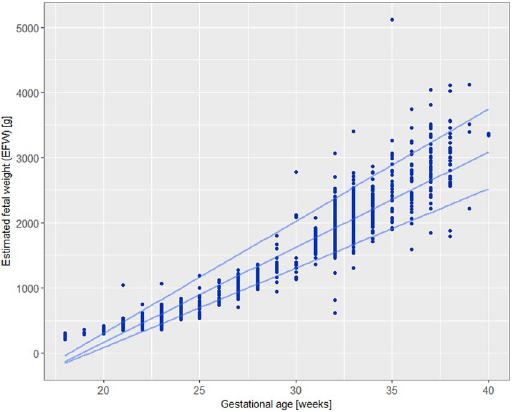
Figure 1. Distribution of Estimated Fetal Weight (grams) according to gestational age (weeks). 5 th , Median and 95 th smooth percentiles are presented with the 3